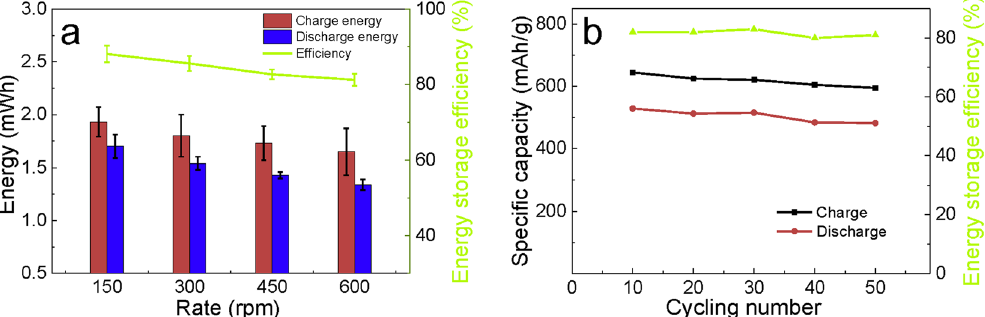
Figure 6. ( a ) Average charge energies of the lithium-sulfur batteries charged by the TENGs at different rotating rates, average discharging energies of the batteries at 0.5 C, and a comparison of the average energy storage efficiencies of the batteries at different rotating rates. Each charge-discharge process is tested for 20 cycles to obtain the average value. ( b ) Cycling performance of the MWCNTs/S/PPy composite at the charge rotating rate of 300 rpm of TENG and the discharge current density of 1